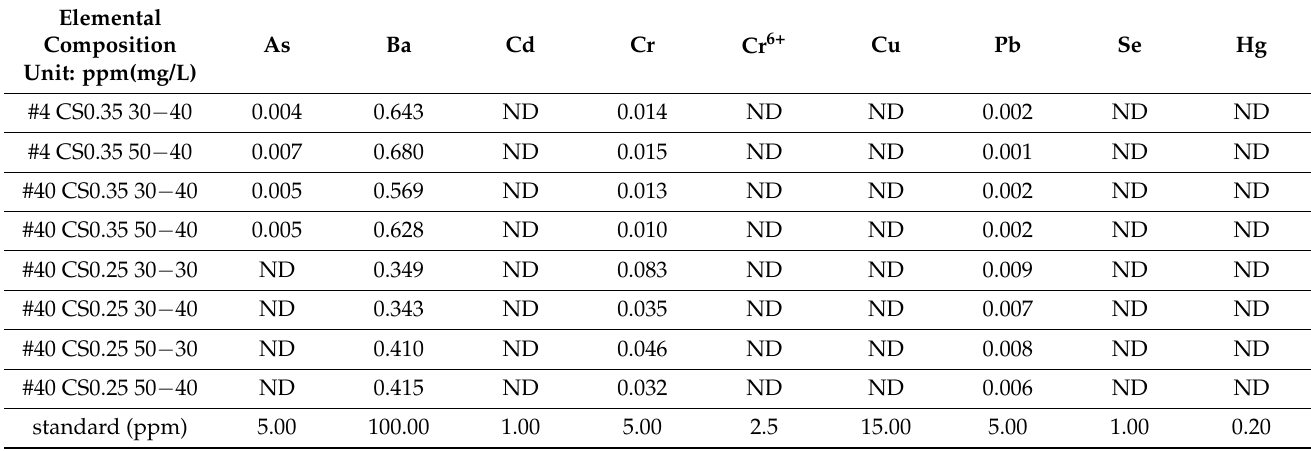
Table 9. Toxicity characteristic leaching procedure of the EAF oxidizing slag